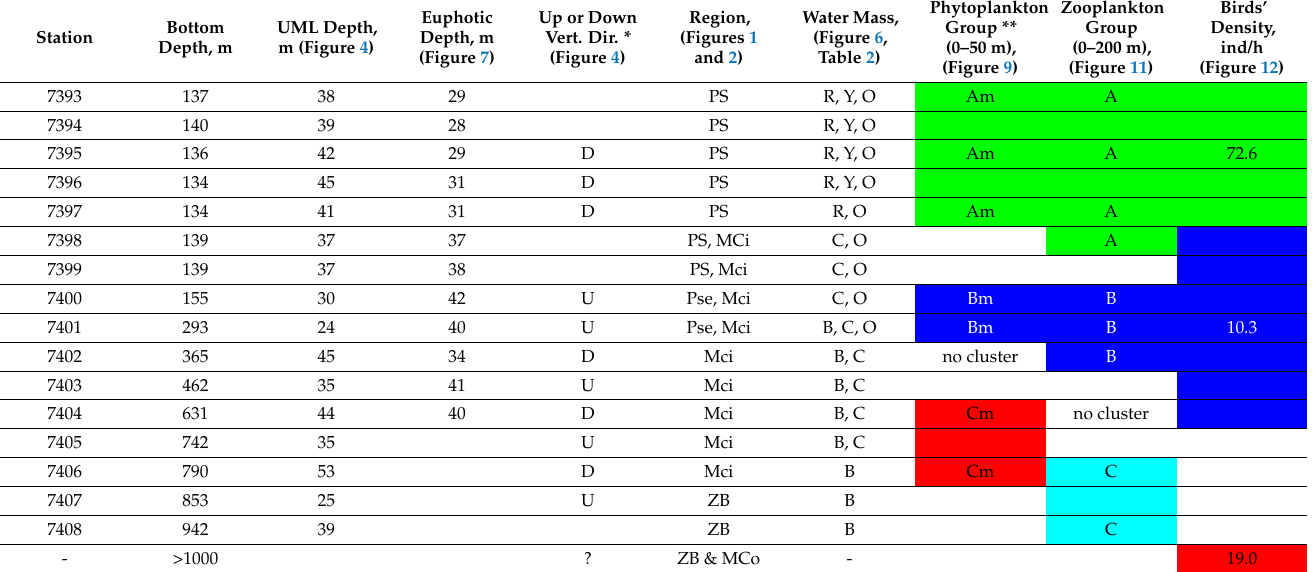
Table 4. Summary information about hydro-physical and biological characteristics of investi- gated waters. The background colors correspond to the colors that mark the planktonic